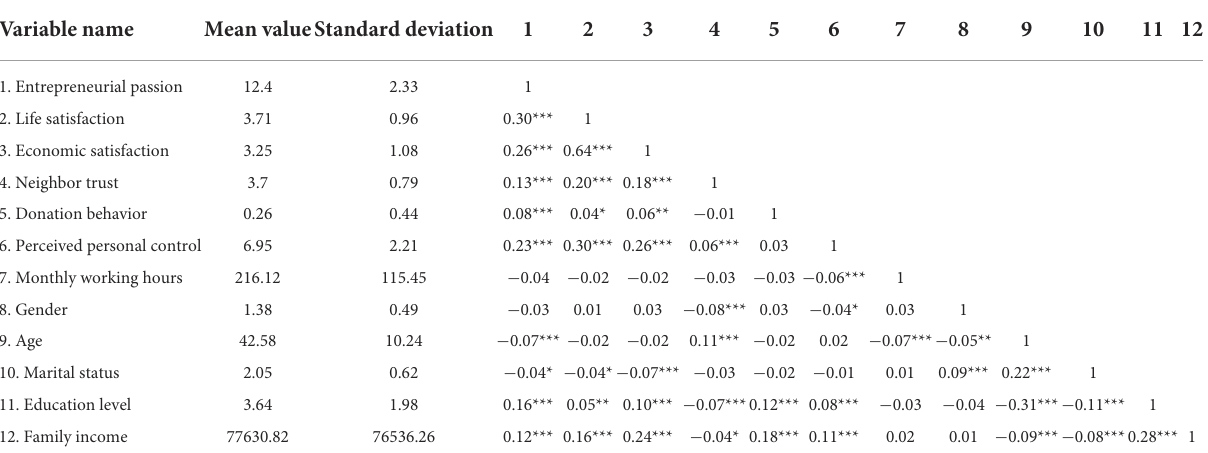
TABLE 1 Descriptive statistics and correlation analysis.